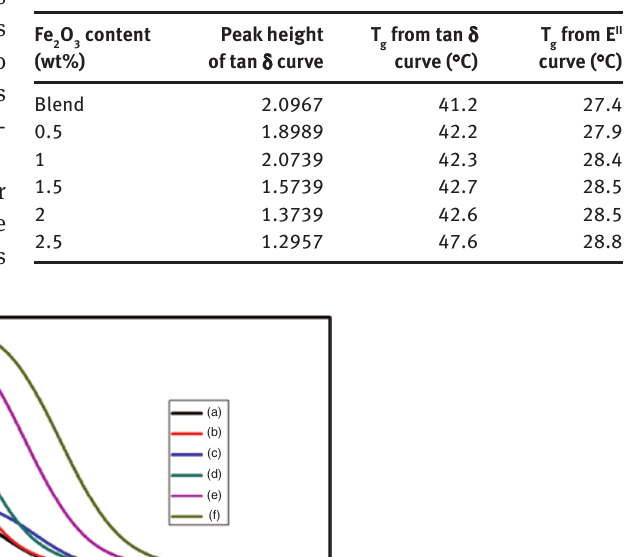
Table 1: Peak height of tan δ curve and T